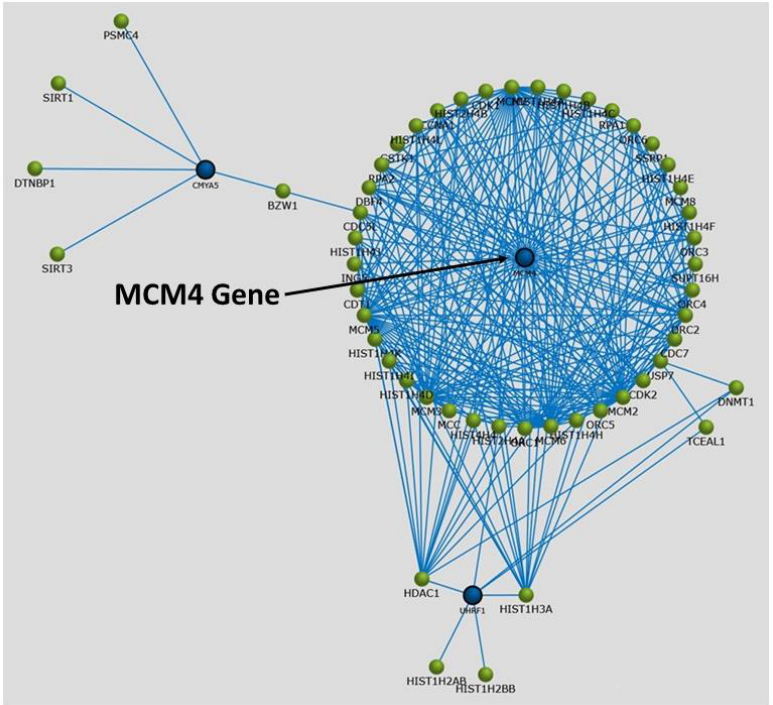
Figure 11. Graphical representation of enrichment analysis and interaction networks obtained through the FunRich database analysis tool for gene annotation pertaining to transcript expression associations in adipose